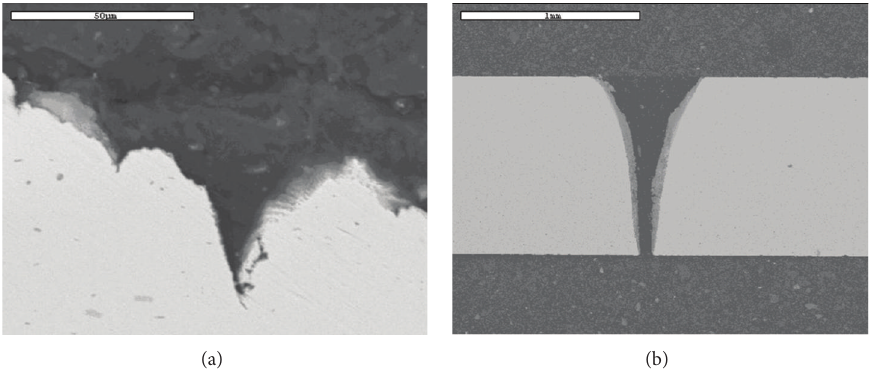
Figure 5: SEM macrographs of cuts with different travel speeds. (a) V = 1 mm/s; (b) V = 0.01